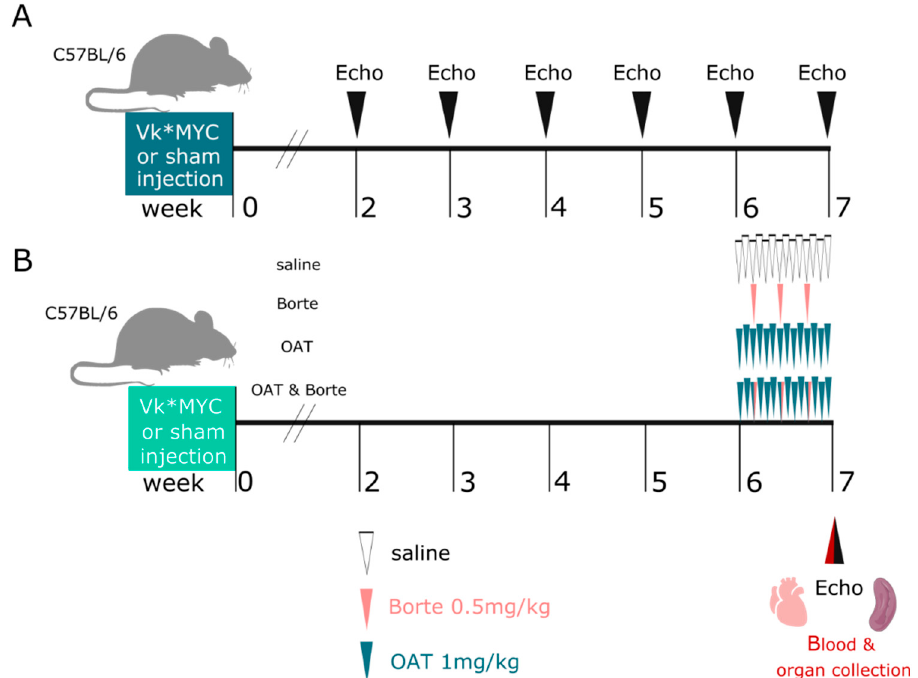
Figure 1. Experimental design In ( A ), mice were inoculated with V ĸ *MYC cells ( n = 18) or received sham injection ( n = 9) and were followed up with serial echocardiography for 7 weeks. In ( B ) V ĸ *MYC inoculated mice ( n = 40) and sham mice ( n = 46) in week 6 were randomized to four subgroups, receiving saline, bortezomib, OAT-1746, or a combination of bortezomib+OAT-1746 for one week. At the end of the experiment, blood was collected, mice were euthanized, spleens were collected, and the hearts were harvested for endothelial function studies.